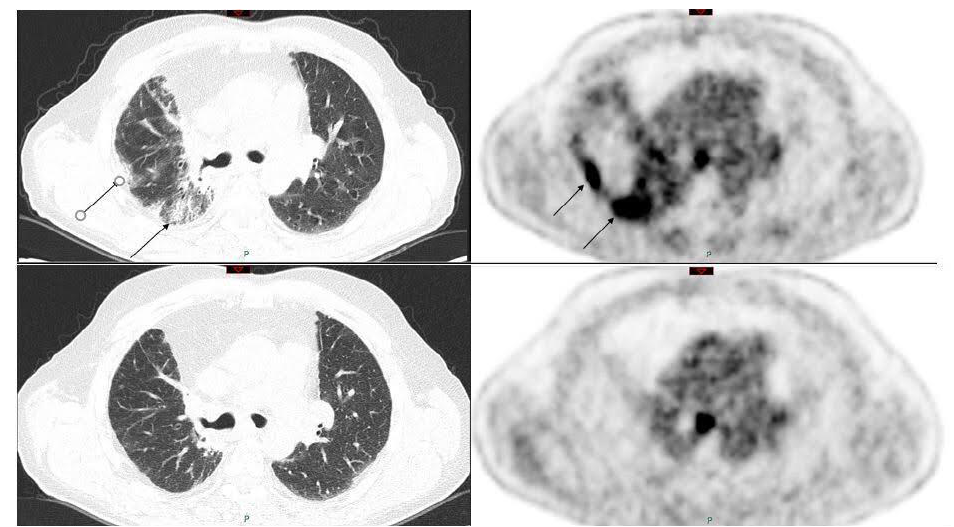
Figure 2. ( Upper row ): pre-therapy 18F-FDG PET/CT of a patient affected by lung cancer in treatment with atezolimumab, showing some areas of increased uptake of the radiopharmaceutical corresponding to mixed ground-glass and crazy paving lung CT alterations (black arrows). ( Lower row ): in PET/CT three months later, after atezolimumab suspension, no more areas of uptake are present, therefore indicative of an immune-related pneumonia.